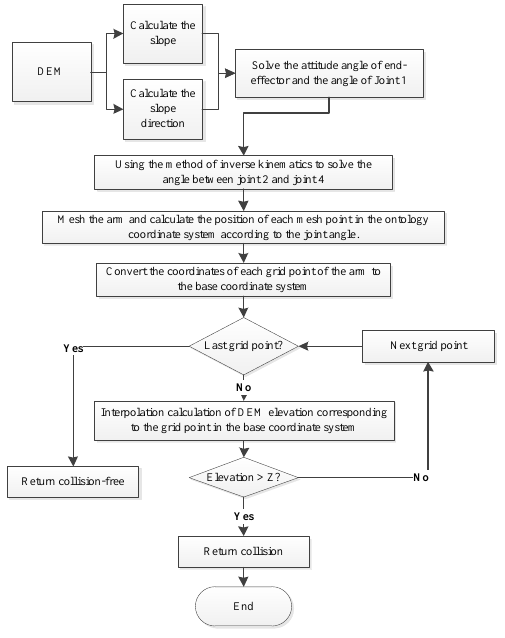
Figure 6. Flow chart of lunar interferometric detection